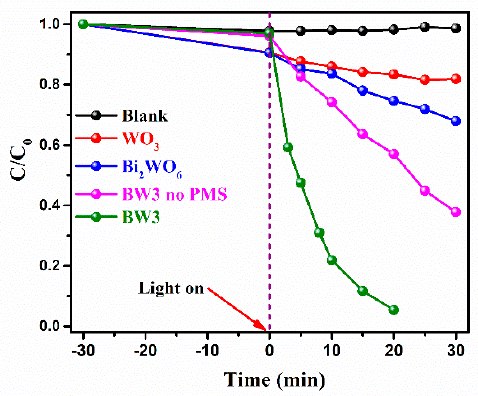
Figure 8. The degradation efficiency of Bisphenol A (BPA) under visible light irradiation over various samples. Reaction condition: initial BPA concentration of 10 mg/L, peroxymonosulfate (PMS) dosage of 0.1 mmol/L, catalyst addition of 1 g/L.